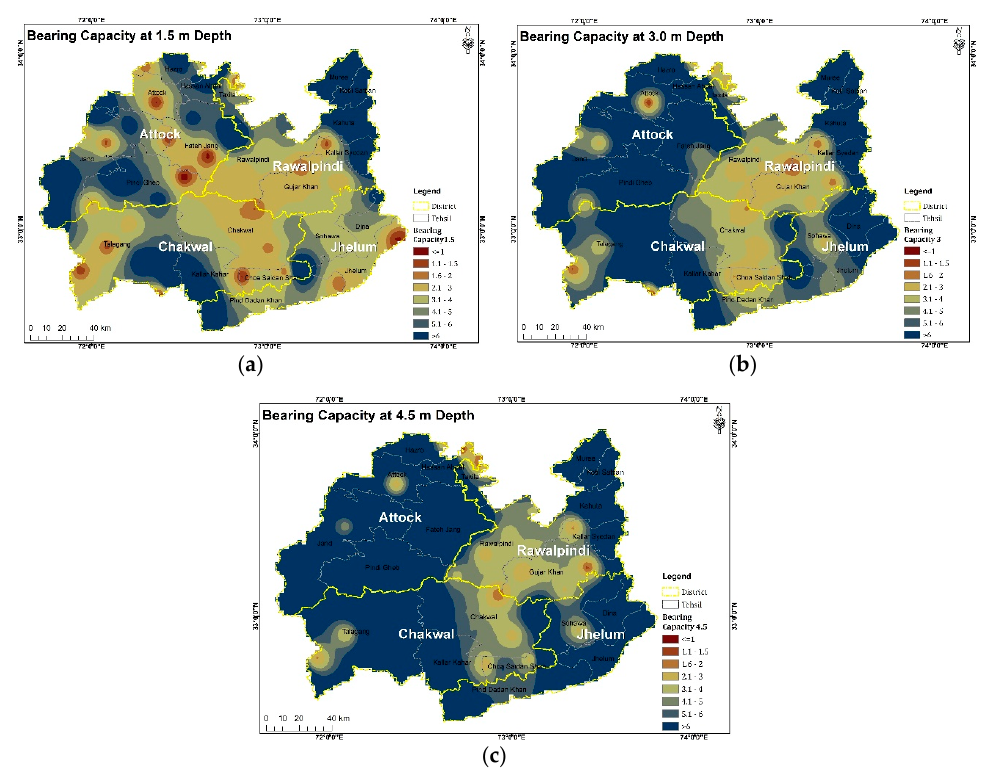
Figure 7. ( a ) Allowable Bearing Capacity at 1.5-m Depth; ( b ) Allowable Bearing Capacity at 3.0-m Depth; ( c ) Allowable Bearing Capacity at 4.5-m depth.